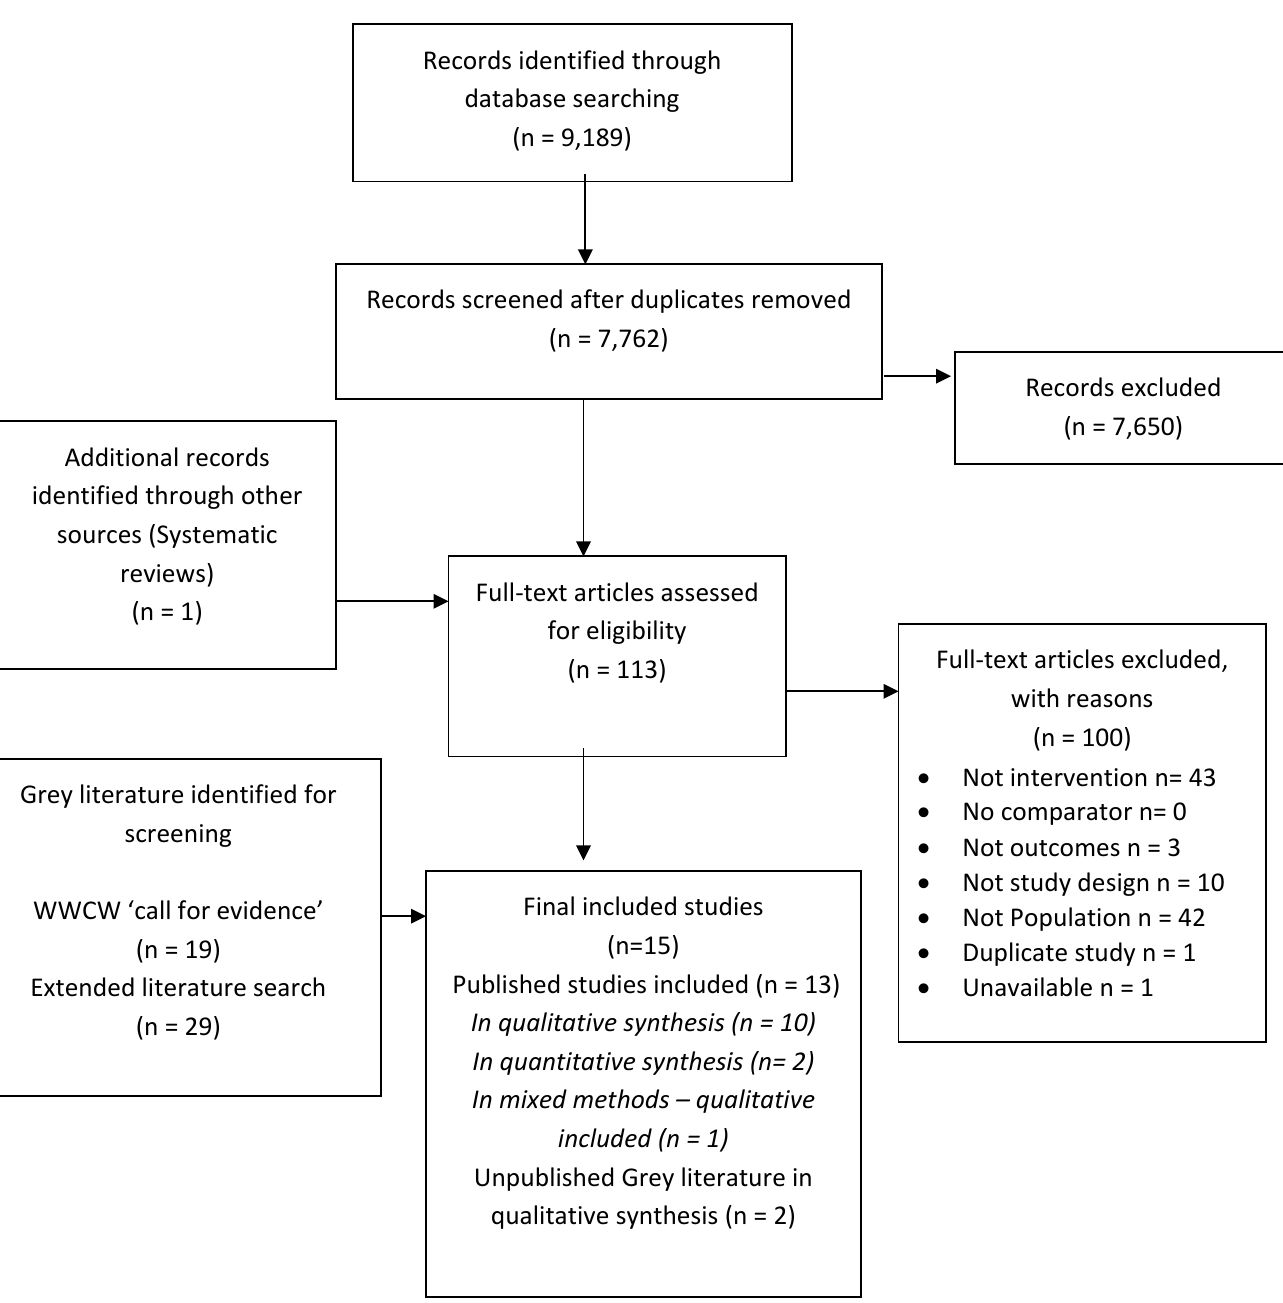
Figure 1: PRISMA flow diagram of the search screening process